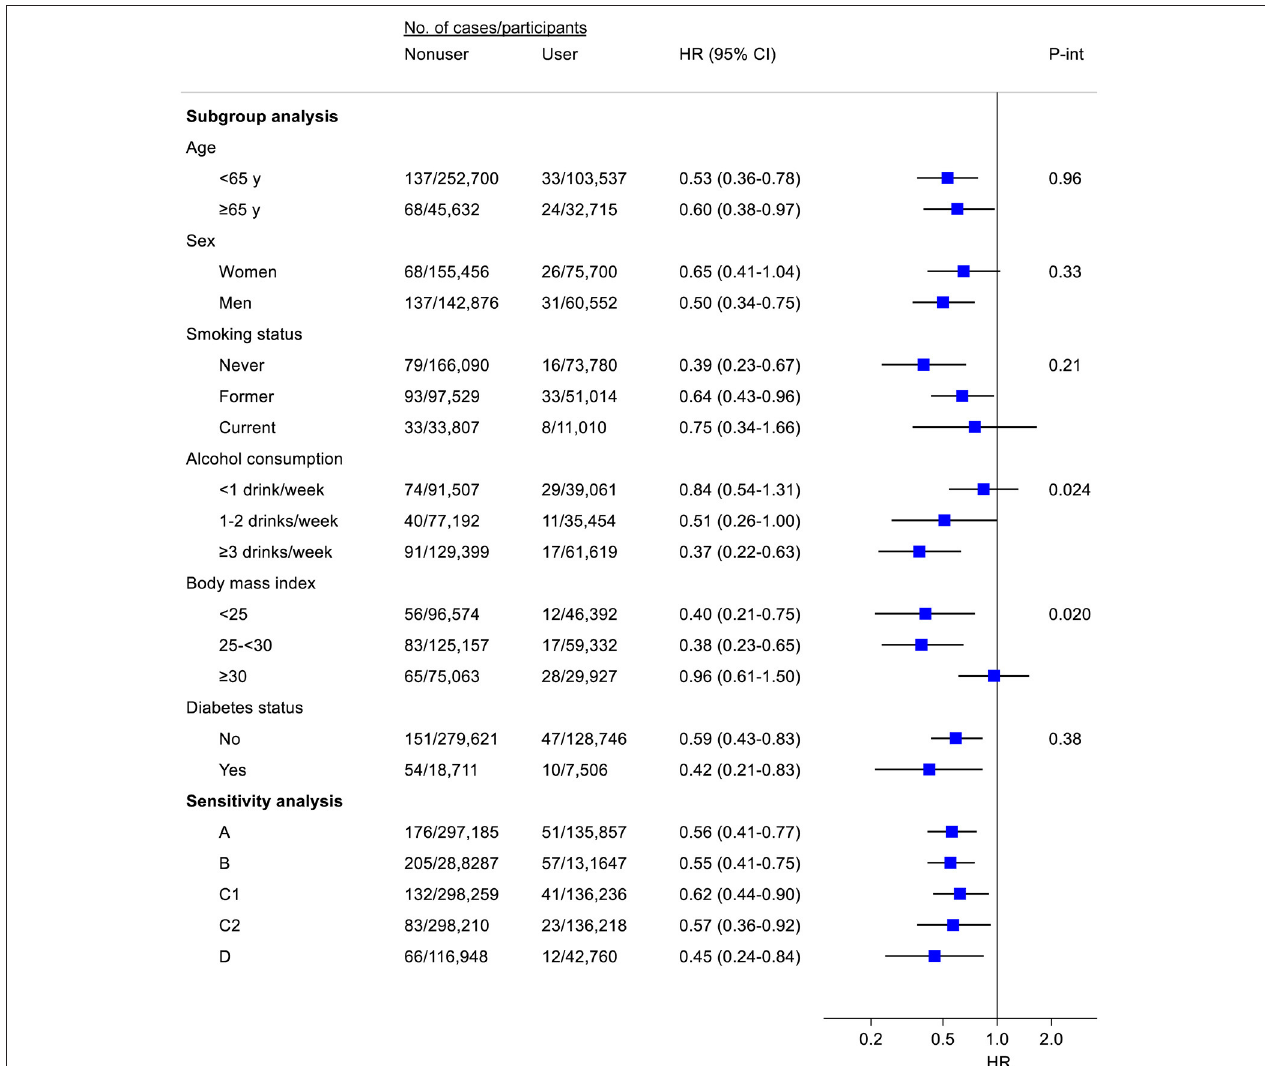
FIGURE 1 | Subgroup and sensitivity analyses for the association of fish oil use with the risk of liver cancer. Where appropriate, results were adjusted for age (y), sex, ethnic group (White, other), Townsend deprivation index, smoking status (never, former, current), pack-years of smoking (for current smokers), alcohol consumption [never, former, current ( < 1, 1–2, ≥ 3 drinks/week)], total physical activity (MET-h/week), dietary factors (consumption of cereal, fresh fruit, fresh vegetables, red meat, processed meat, oily fish, non-oily fish, and coffee), body mass index (kg/m 2 ), diabetes, and blood measures of liver function ( z scores of alanine aminotransferase and total bilirubin). A, Excluding participants with viral hepatitis, alcoholic liver disease, or liver fibrosis/cirrhosis; B, Excluding non-liver cancer deaths during follow-up; C, Excluding incident cases of liver cancer within the first 3 (C1) or 5 (C2) years of follow-up; D, Among participants ( n = 187,120) with ≥ 1 24-h dietary recall, risk of liver cancer for participants who reported fish oil use both at baseline and at ≥ 1 of 24-h dietary recalls vs. risk for participants who neither reported fish use at baseline nor during 24-h dietary recalls. Participants ( n = 27,334) who reported fish oil use at baseline or 24-h dietary recalls only were excluded from this